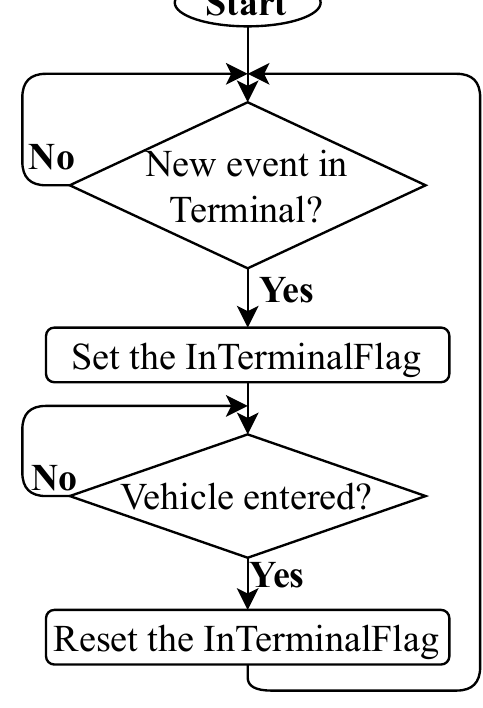
Figure 10. Flowchart of Entrance Terminal Ticket.